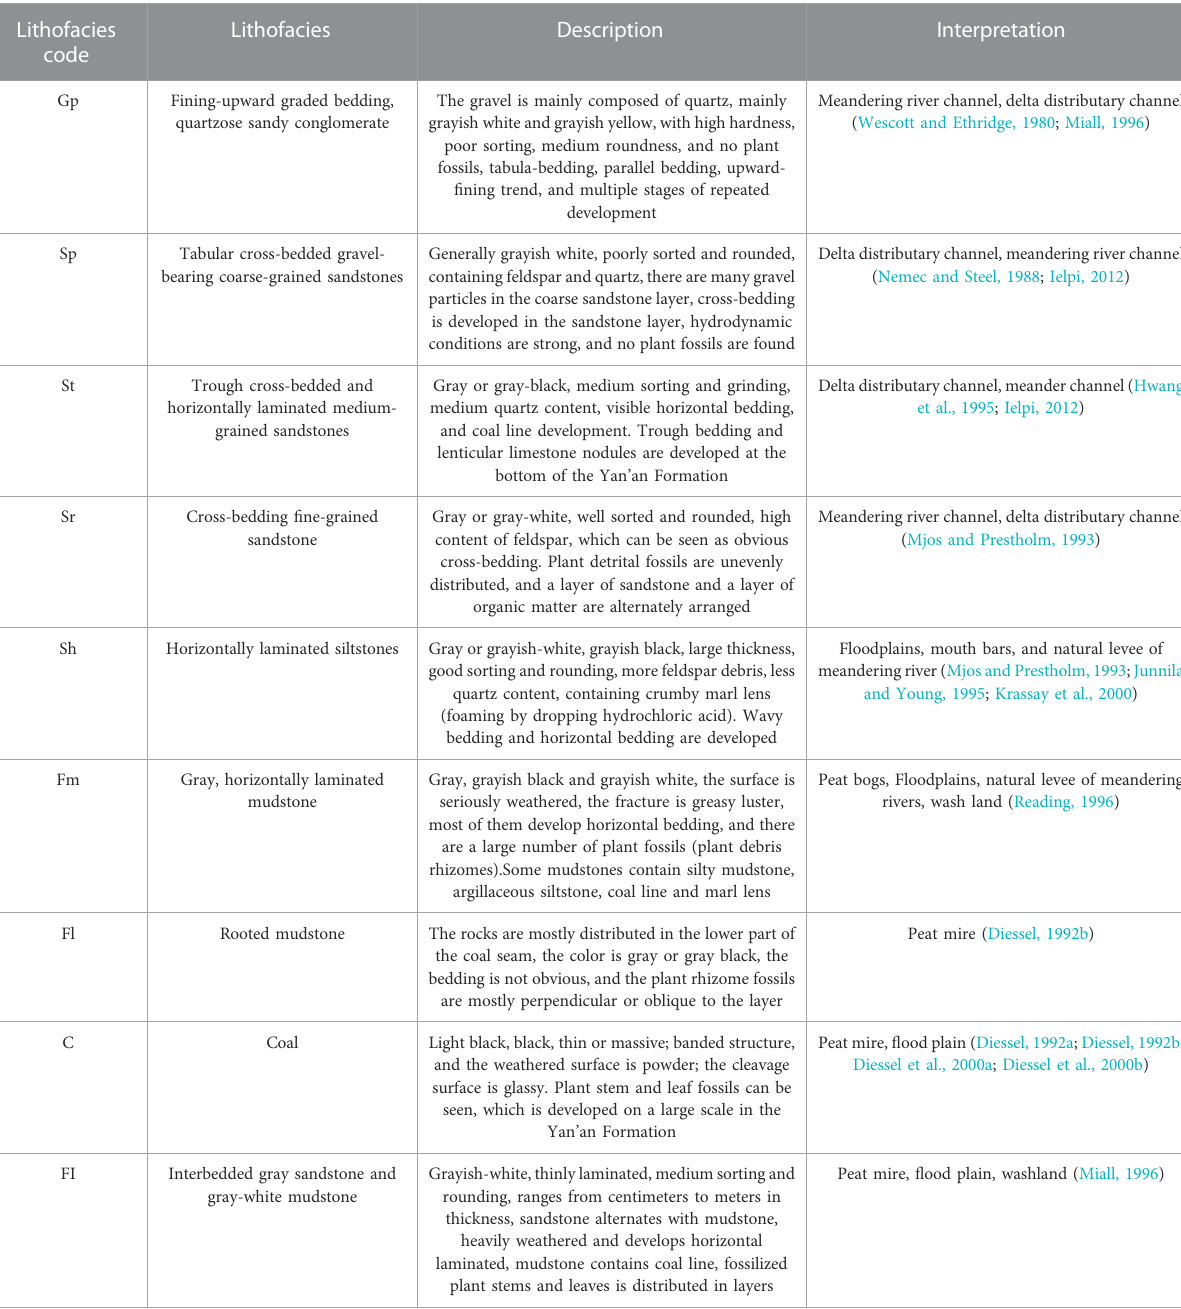
TABLE 1 Main lithofacies of the Yan ’ an Formation in the Dongsheng Coal fi eld of the Ordos